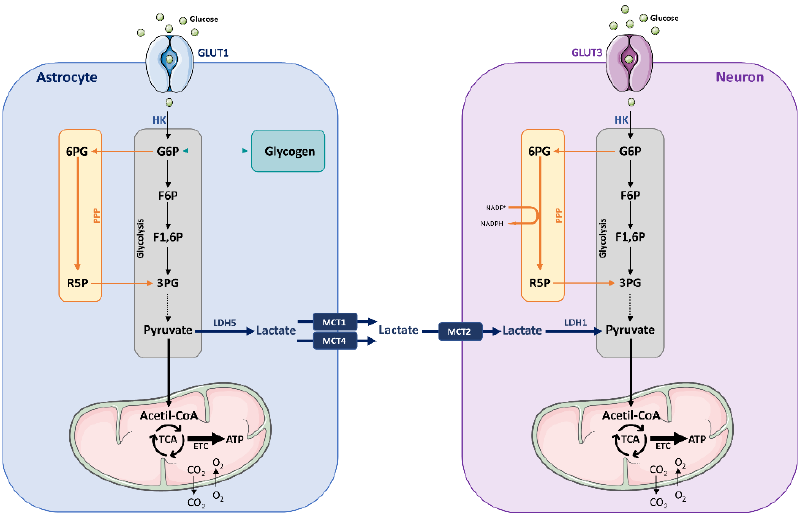
Figure 1. Different metabolic strategies used by neurons and astrocytes. In astrocytes, glucose is imported through glucose transporter 1 (GLUT1) and preferentially stored as glycogen, or metabolized via glycolysis. The generated pyruvate is converted to lactate thanks to the expression of lactate dehydrogenase 5 (LDH5). Glucose enters neurons via GLUT3, and once inside the cell is phosphorylated by hexokinase (HK), resulting in glucose ‐ 6 ‐ phosphate (G6P) subsequently directed to the pentose phosphate pathway (PPP) and the glycolytic pathway. The final product of glycolysis is pyruvate, which after entering the mitochondria will be subjected to the tricarboxylic acid (TCA) cycle, and subsequently to oxidative phosphorylation consisting of the electron transport chain (ETC). This process consumes O 2 and leads to the production of ATP and CO 2 . G6P undergoing PPP is transformed into 6 ‐ phosphogluconate (6PG), and is thereafter converted to ribulose ‐ 5 ‐ phosphate (R5P). In this process, nicotinamide adenine dinucleotide phosphate (NADPH) is produced, an essential molecule to regenerate oxidized antioxidants. The weak glycolytic activity of neurons may reduce pyruvate formation and, therefore, obtain limited energy production in mitochondria from glucose metabolism. However, this may be compensated by the uptake of lactate from astrocytes, given that glutamate stimulates lactate release from astrocytes (astrocyte–neuron lactate shuttle; ANLS). Abbreviations are as follows: 3PG, 3 ‐ phosphoglycerate; 6PG, 6 ‐ phosphogluconate; ETC, electron transport chain; F6P, fructose ‐ 6 ‐ phosphate; F1,6P, fructose ‐ 1,6 ‐ diphosphate; G6P, glucose ‐ 6 ‐ phosphate; LDH, lactate dehydrogenase; MCT, monocarboxylic acid transporter; NADPH, nicotinamide adenine dinucleotide phosphate; PPP, pentose phosphate pathway; R5P, ribulose ‐ 5 ‐ phosphate; TCA, tricarboxylic acid.